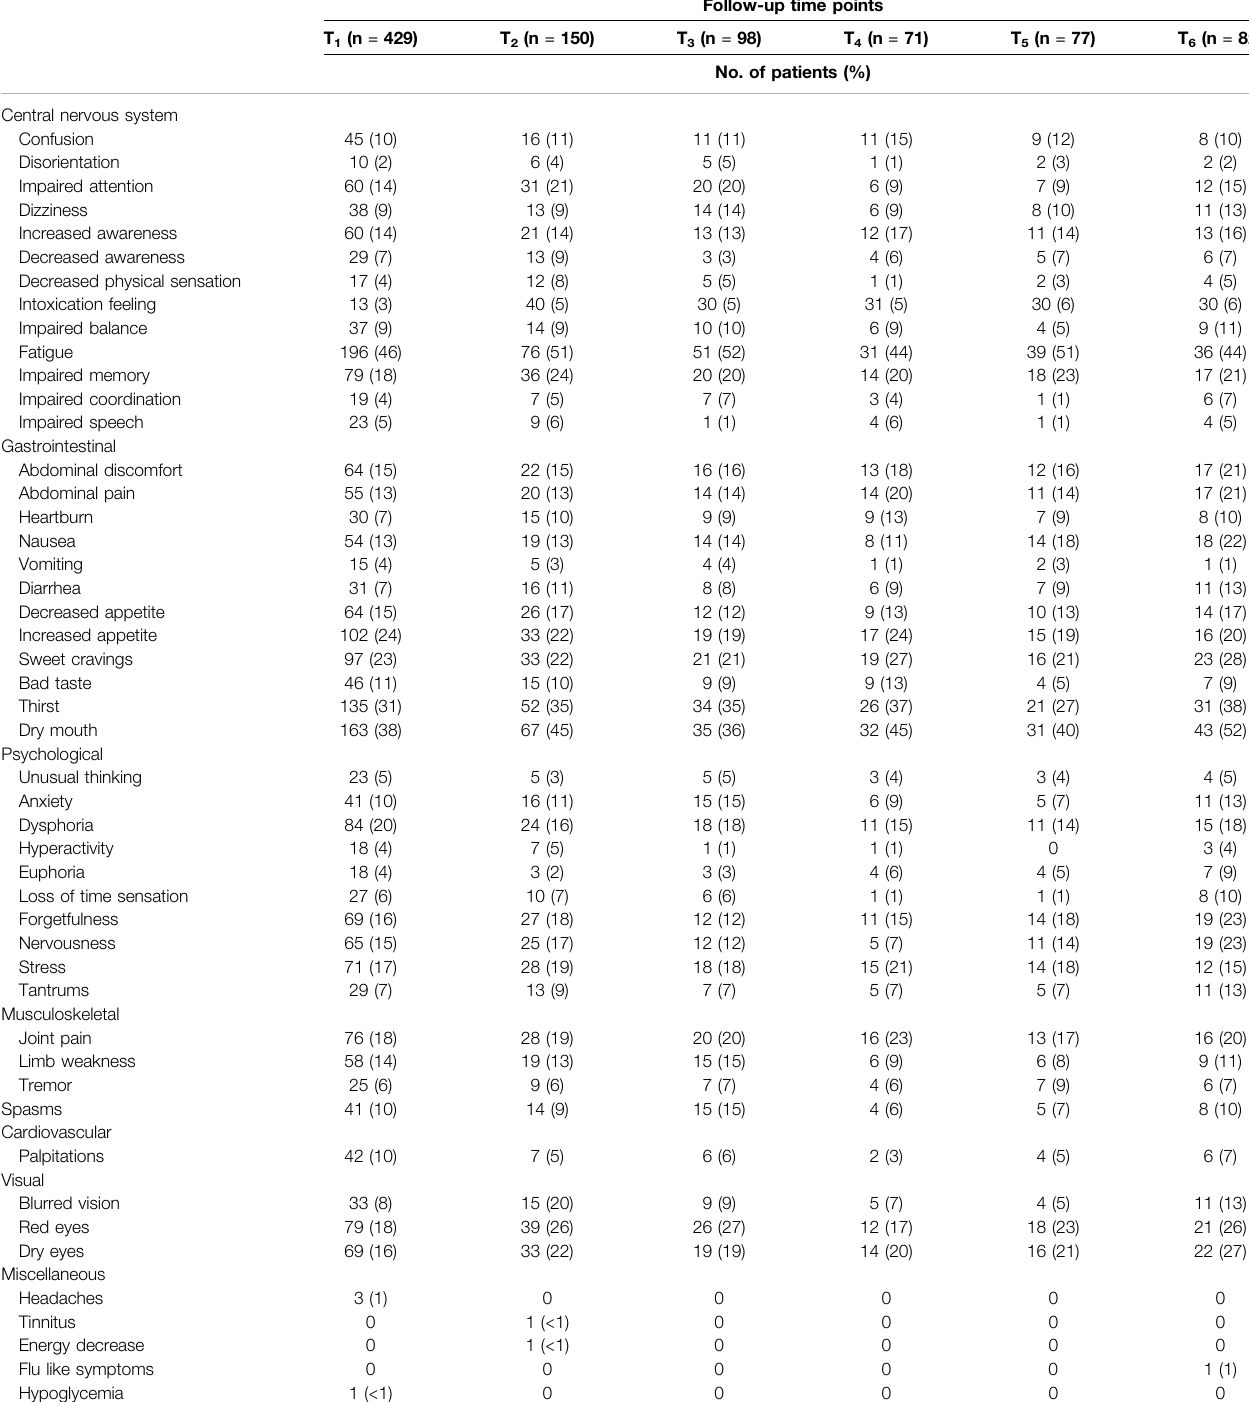
TABLE 4 | Speci fi c medical cannabis related adverse effects rates of the study sample at one month intervals within a six-month